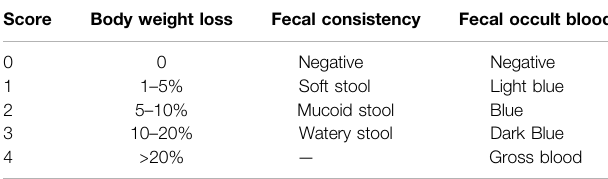
TABLE 2 | Disease activity index (DAI) scoring